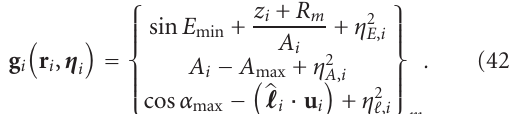
Figure 3: Sparsity pattern for the Jacobian D F ( X ) in the FDM-RV